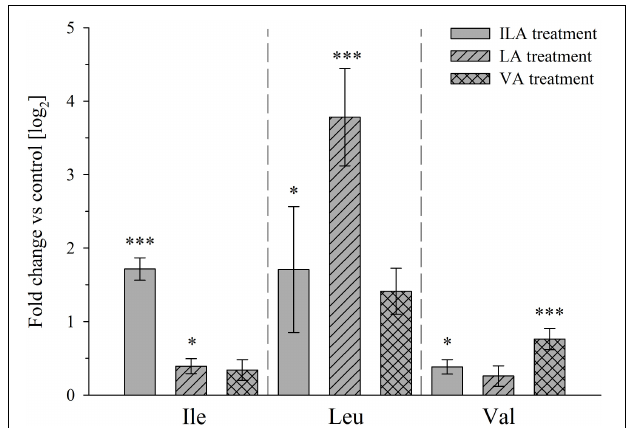
FIGURE 6 | Branched-chain amino acid levels after exogenous application of 2-HAs to A. thaliana plants. Rosette leaves of 4-week-old A. thaliana Col-0 plants were harvested 24 h after spraying with 1 mM ILA, LA, or VA and extracted for BCAAs analysis. Means ± SE of log fold change of 2-HA treatments vs. mock are presented; ( n = 8). Asterisks indicate statistically significant differences between treatment and mock ( ANOVA ), ∗ p -value < 0.05, ∗∗∗ p -value < 0.001. Note that the BCAA corresponding to a particular 2-HA is specifically induced indicating a metabolic relationship, while the respective other BCAAs are not affected or affected at a much lower extent.